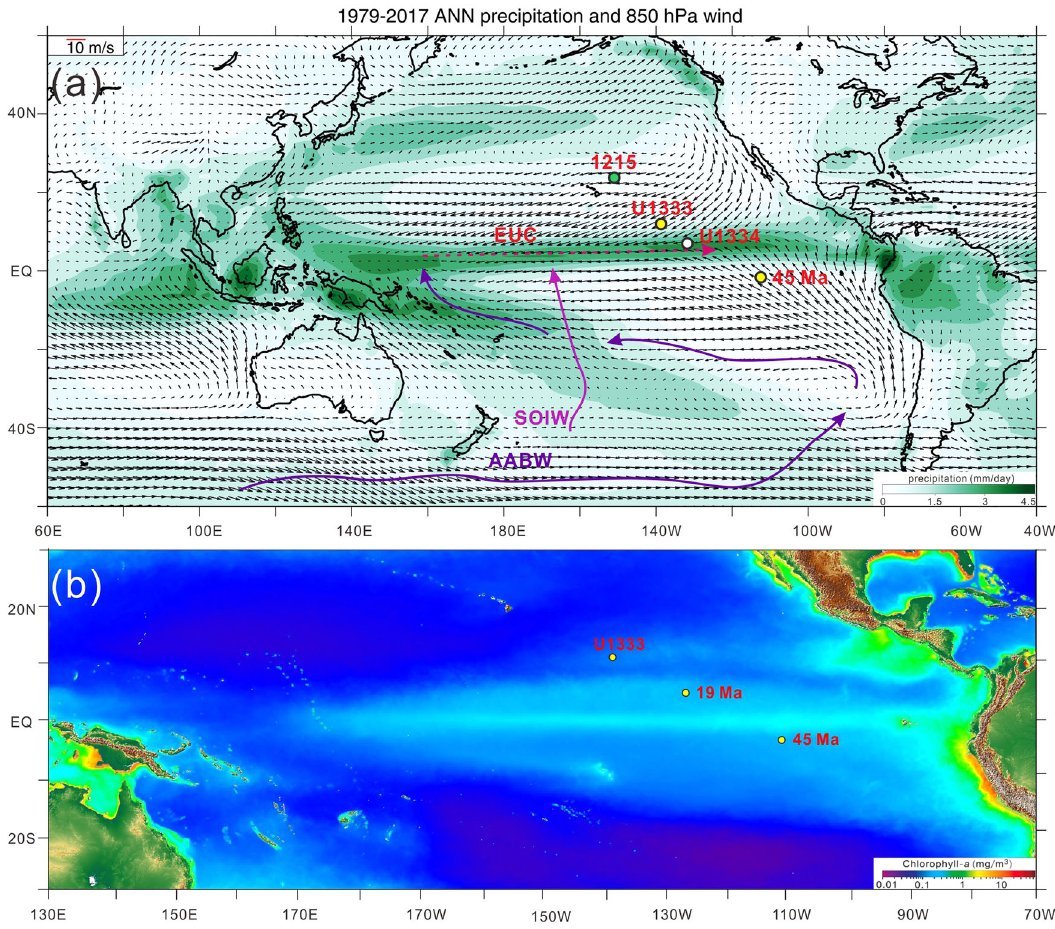
Fig. 1 Location map. a Overview of wind fi elds 63 and the Paci fi c Ocean current system 64 . Yellow circles indicate the modern (10.52°N, 138.42°W) and past position of Site U1333 at 45 Ma (3.95°S, 111.20°W). White and green circles indicate the locations of Site U1334 and Site 1215, respectively.